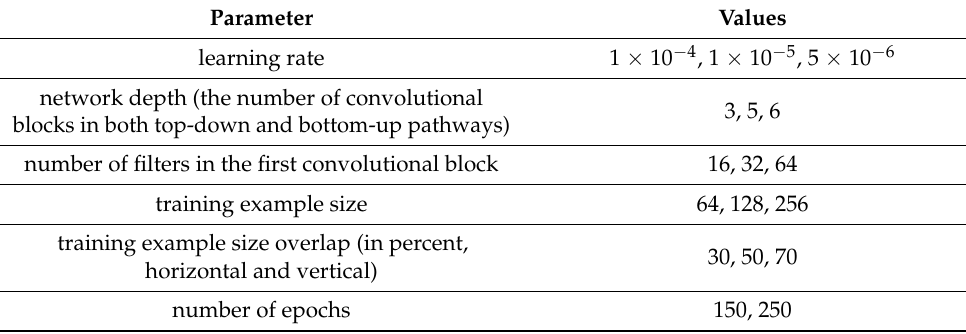
Table 2. Hyperparameters considered during the training.